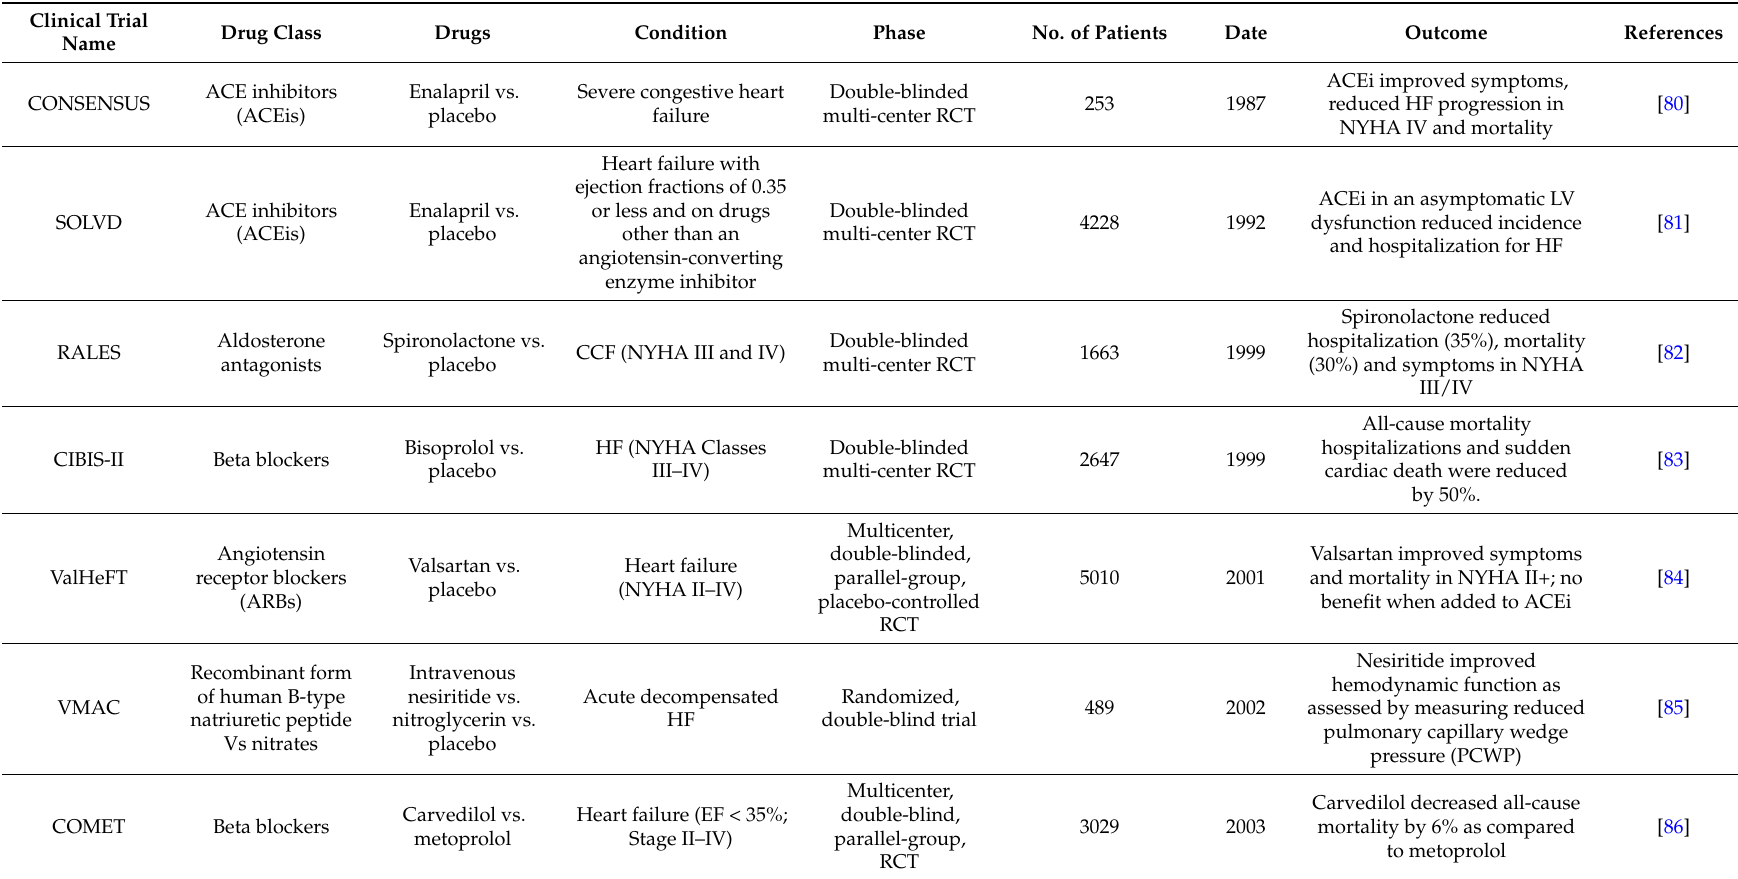
Table 2. Pharmacological and Non-Pharmacological Clinical Trials for